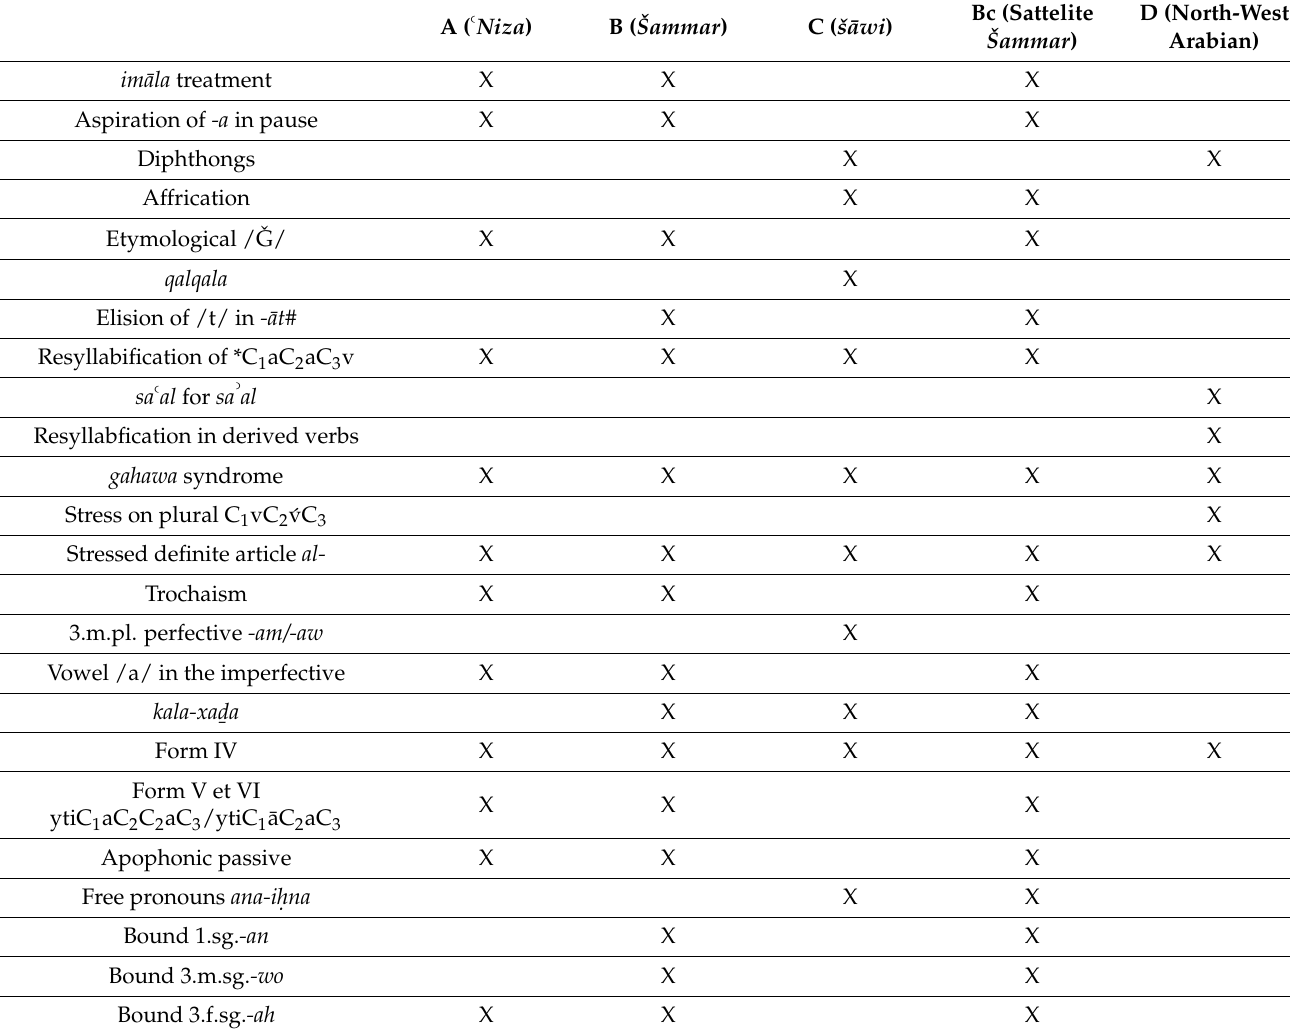
Bc (Sattelite D (North-West Šammar )